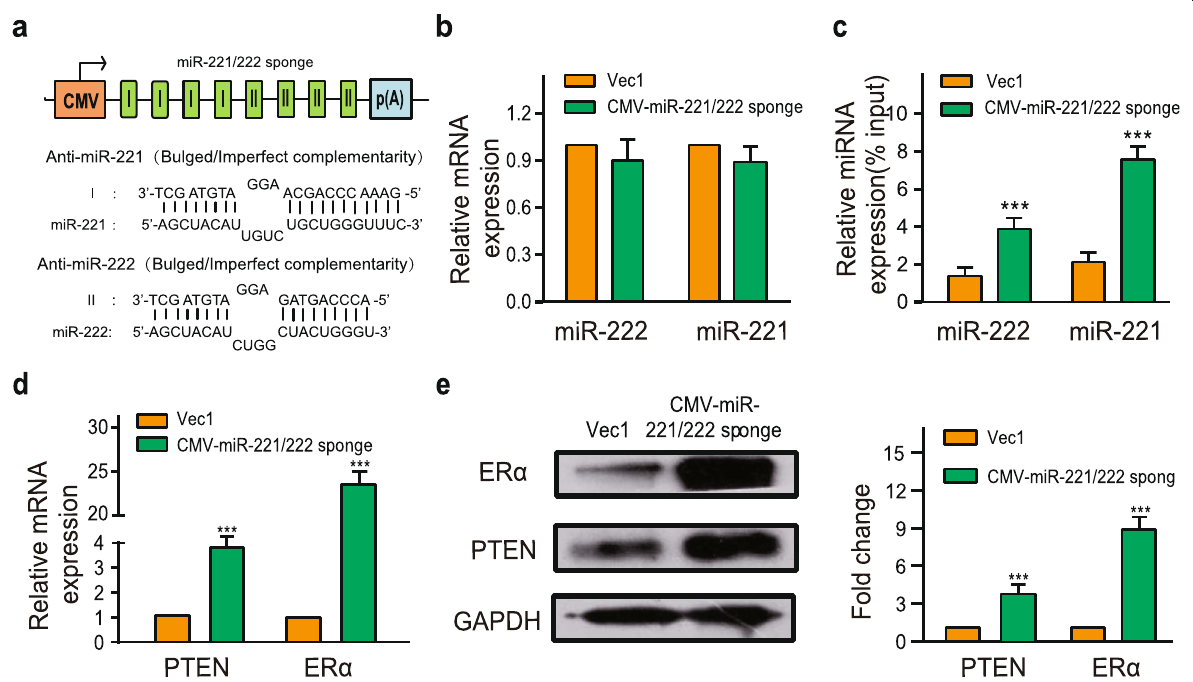
Fig. 3 The CMV-miR-221/222 sponge combined miR-221 and miR-222 to de-repress ER α and PTEN expression in MCF-7 TamR cells. a Schematic of the miR-221/222 sponge expression cassette. I: bulged/imperfect complementarity towards miR-221; II: bulged/imperfect complementarity towards miR-222. b The expression of miR-221 and miR-222 was analyzed by qRT-PCR 48 h after the transfection of the CMV-miR-221/222 sponge. Simultaneously, a biotin-labelled miR-221/222 sponge probe was used to pulldown miR-221 and miR-222. Then the amount of miR-221 and miR-222 was assessed by qRT-PCR ( c ). In addition, qRT-PCR and western blotting were used to explore the expression of ER α and PTEN after the transfection of the miR-221/222 sponge expressing vector in MCF-7 TamR cells ( d , e ). Data in b-e were presented as the mean ± SD ( n = 3). *** p <